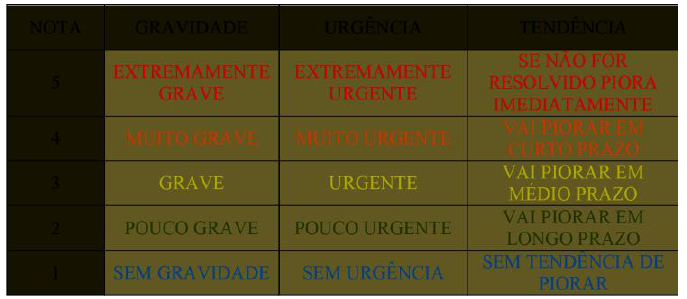
cada 1.000 kg processados. Sendo que na fábrica se processam 3.400 kg/dia, conforme são apresentados na tabela 8. Tabela 8: Relação de dados do desperdício no descascamento.